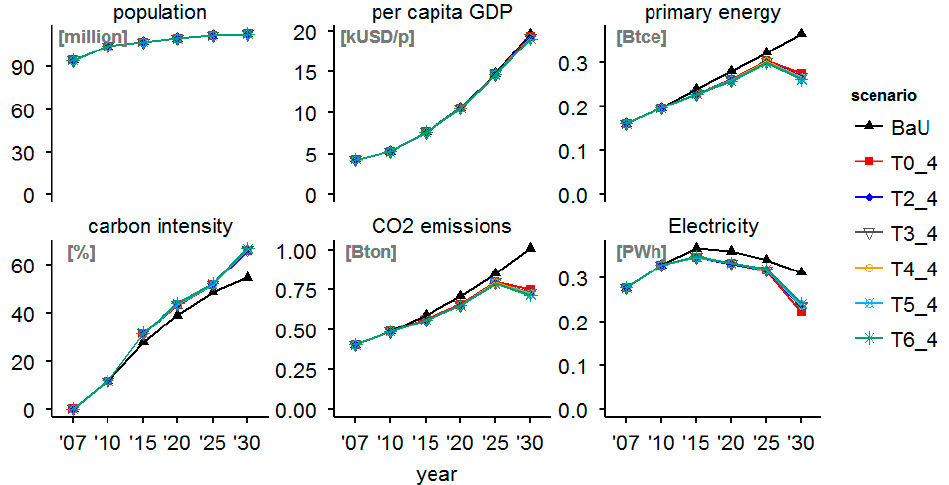
Figure 2. Trajectory of main indicators of economy, energy, and emissions of Guangdong Prov- ince.